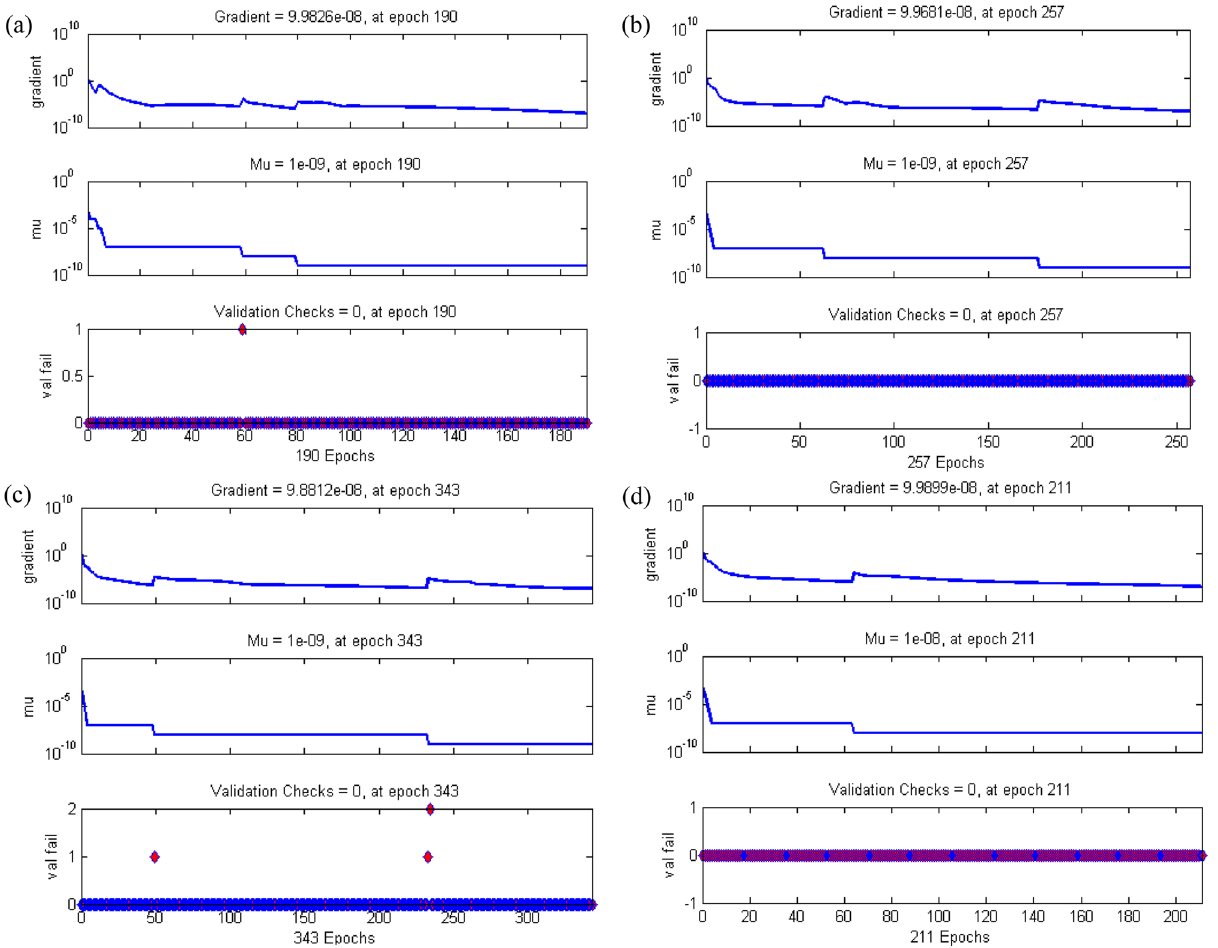
Figure 10. Plot training state of case study 1: scenario 1 ( a ) case 1, ( b ) case 2, ( c ) case 3 and ( d ) case